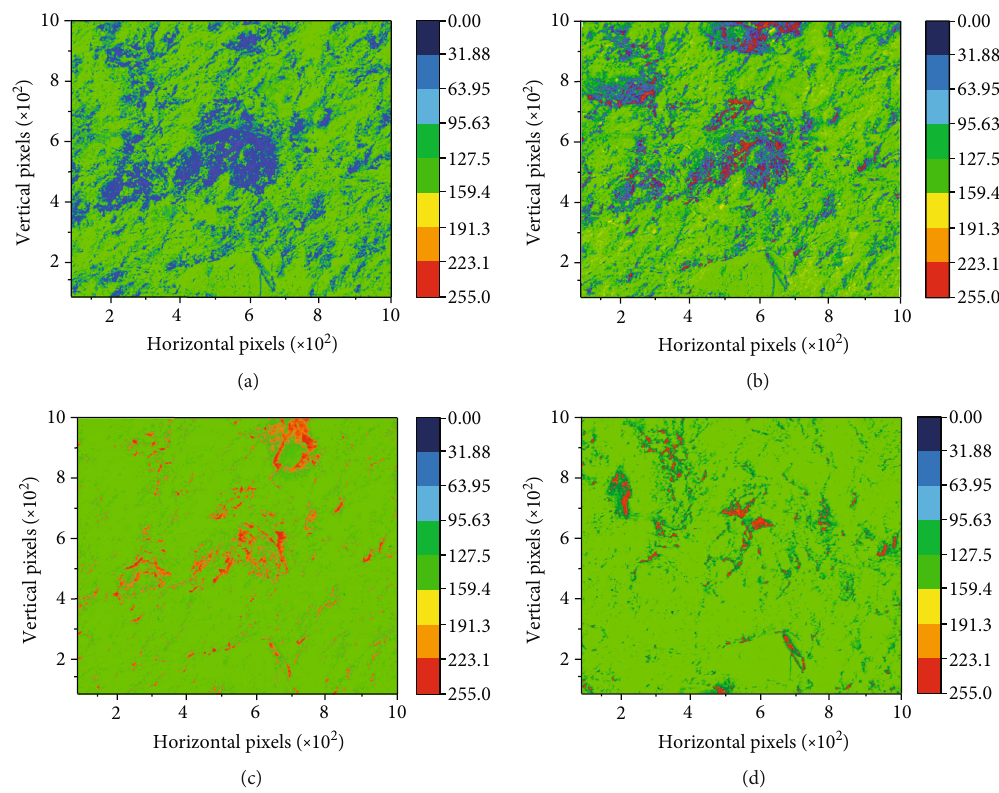
Figure 10: Color/gray distribution of oil shale before and after conduction-based heating. (a) Oil shale in initial state. (b) Oil shale at 300 ° C. (c) Oil shale at 400 ° C. (d) Oil shale at 500 °